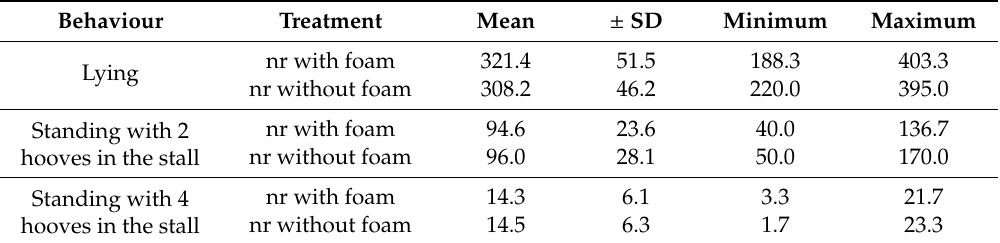
Table 1. Time of stall occupation including three kinds of cow activities in the experiment with neck rail (nr), in (min · d − 1 · stall − 1